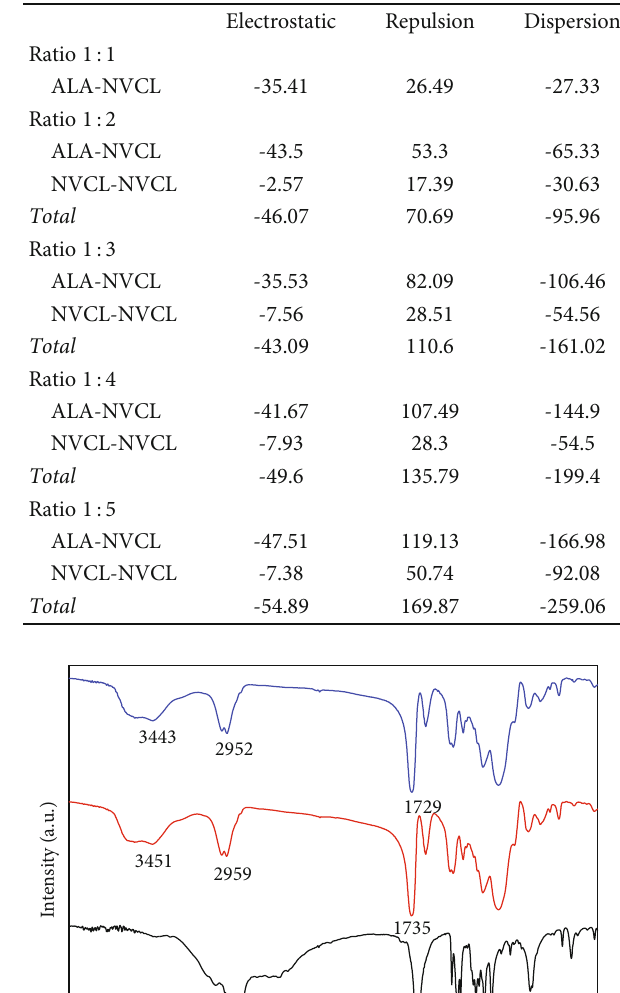
Table 3: The energy decomposition of ALA-NVC complex. ) and the basis set binding